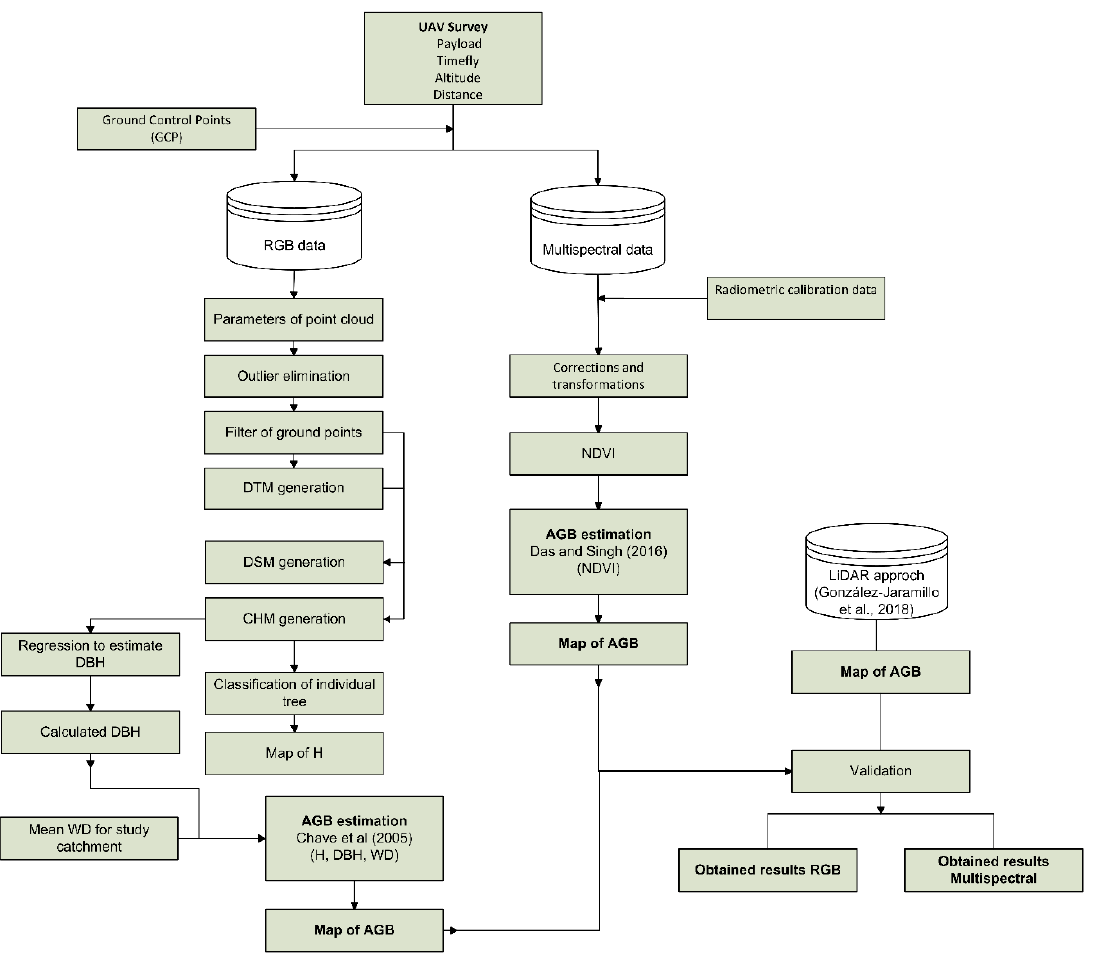
Figure 4. Processing chain to estimate above-ground biomass AGB (Mg ha − 1 ) using RGB (left) and multispectral imagery (right).